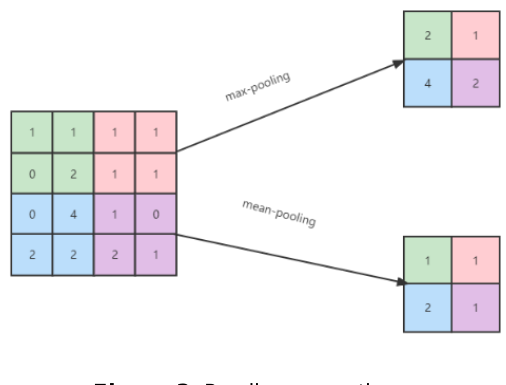
Figure 3. Pooling